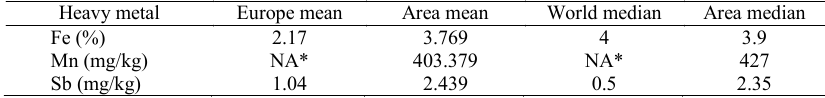
Table 4: Comparison of the concentrations of elements in the studied area with the values from the region, Europe, and the world (Facchinelli et al., 2001; Franco-Uria et al., 2009)